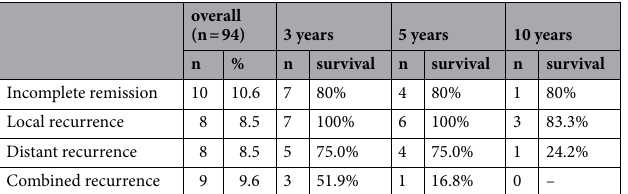
Table 2. Overall survival depending on remission status and metastasis. n = patients at risk; combined recurrence = simultaneous locoregional and distant recurrence.